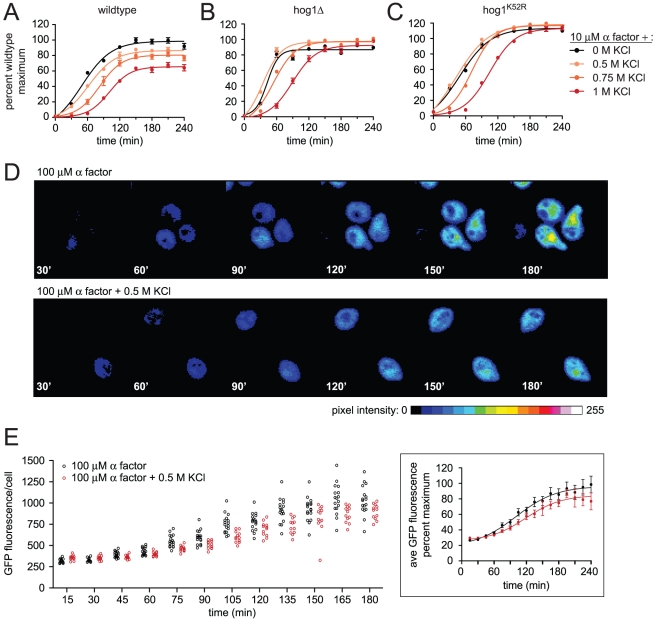
Hyperosmotic stress delays and dampens mating transcription.Transcriptional activation (β-galactosidase activity) was measured spectrofluorometrically every 30 min in (A) wild-type, (B) hog1Δ, and (C) hog1K52R cells transformed with a plasmid containing a pheromone-inducible reporter (FUS1-lacZ). Transcription was induced by the addition of 10 µM α factor, 10 µM α factor+0.5 M KCl, 10 µM α factor+0.75 M KCl, or 10 µM α factor+1 M KCl. Data are the mean ± SE of four individual colonies measured in quadruplicate and presented as percentage of wild-type maximum. Transcriptional activation (GFP expression) was measured by fluorescence microscopy in individual wild-type cells with an integrated pheromone-inducible reporter (FUS1-GFP). (D) Representative images of GFP expression in G1 cells stimulated by the addition of 10 µM α factor or 10 µM α factor+0.5 M KCl. Color spectrum indicates GFP pixel intensity as calculated using ImageJ. (E) Scatter plot of GFP fluorescence (average pixel intensity/cell area) in individual cells stimulated with 10 µM α factor or 10 µM α factor+0.5 M KCl. Insert is the average GFP intensity from the population of individual cells in (E), error bars indicate 95% CI.